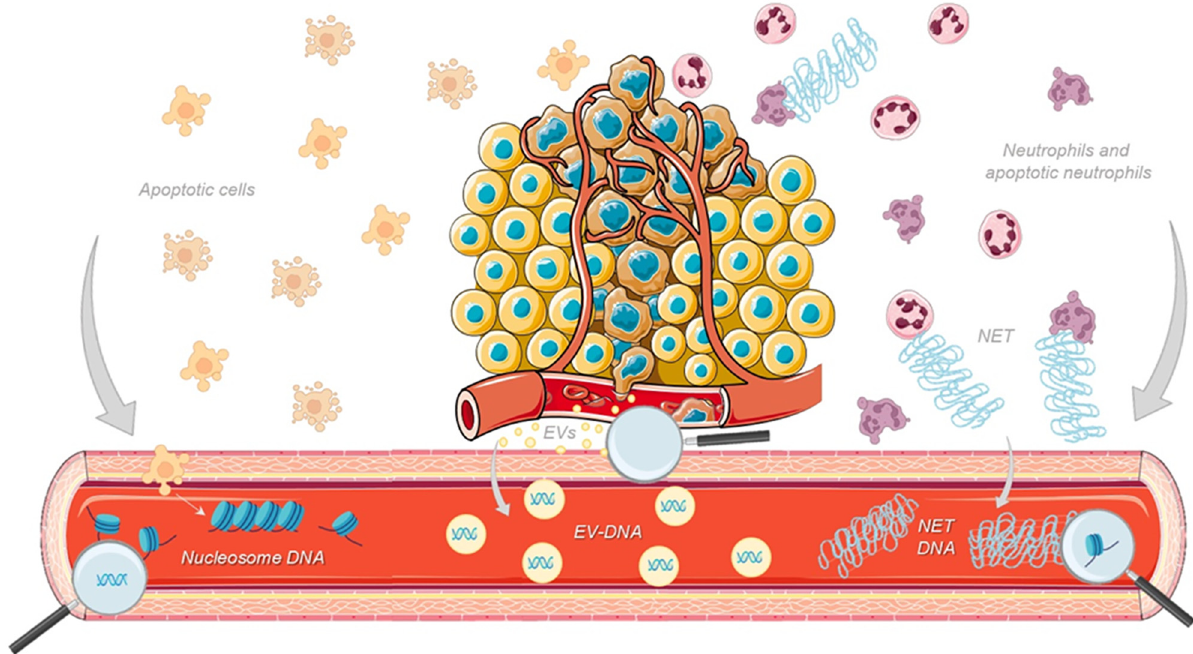
Figure 1: Main cfDNA